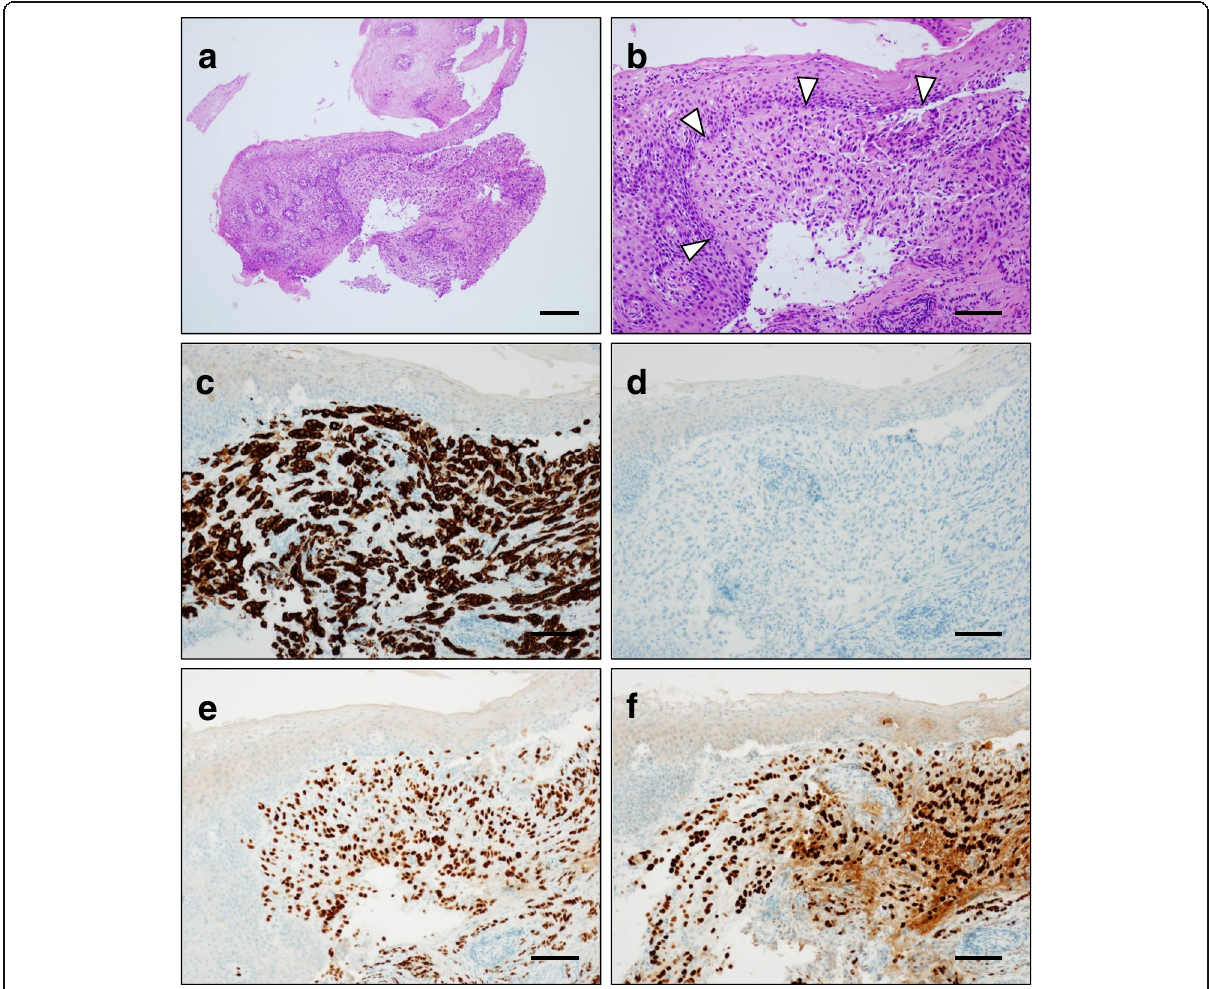
Fig. 2 Histopathological findings of the esophageal tumor. Hematoxylin-eosin staining of biopsy specimens shows a subepithelial luminal structure and dysplastic cells covered with normal squamous epithelia ( a low-power view, b high-power view). Immunostaining was positive for CK7 ( c ), negative for CK20 ( d ), positive for ER ( e ), and positive for PgR ( f ). Scale bars, 200 μ m ( a ) and 100 μ m ( b - f